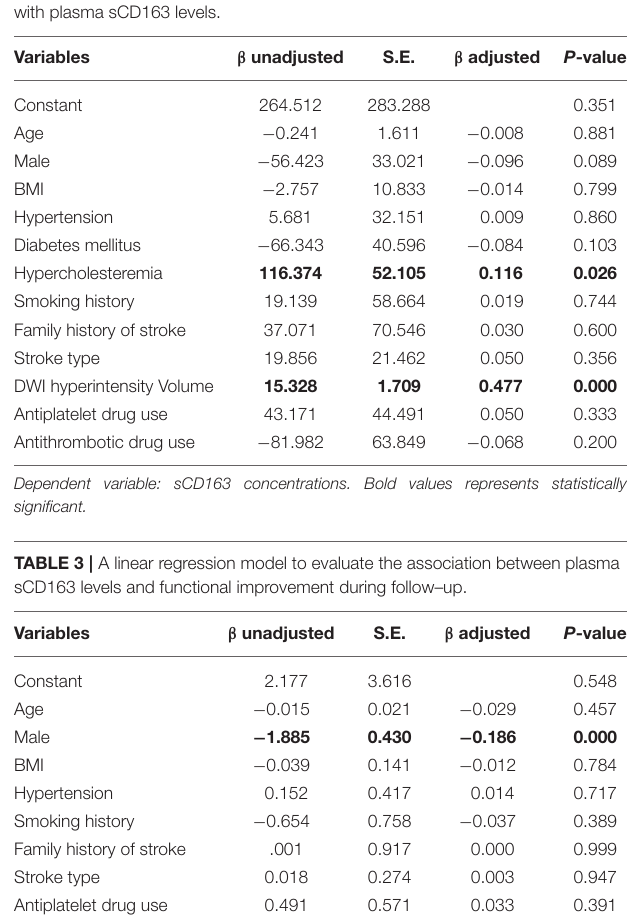
TABLE 4 | A logistic regression model to evaluate risk factors of poor functional outcome during follow-up.